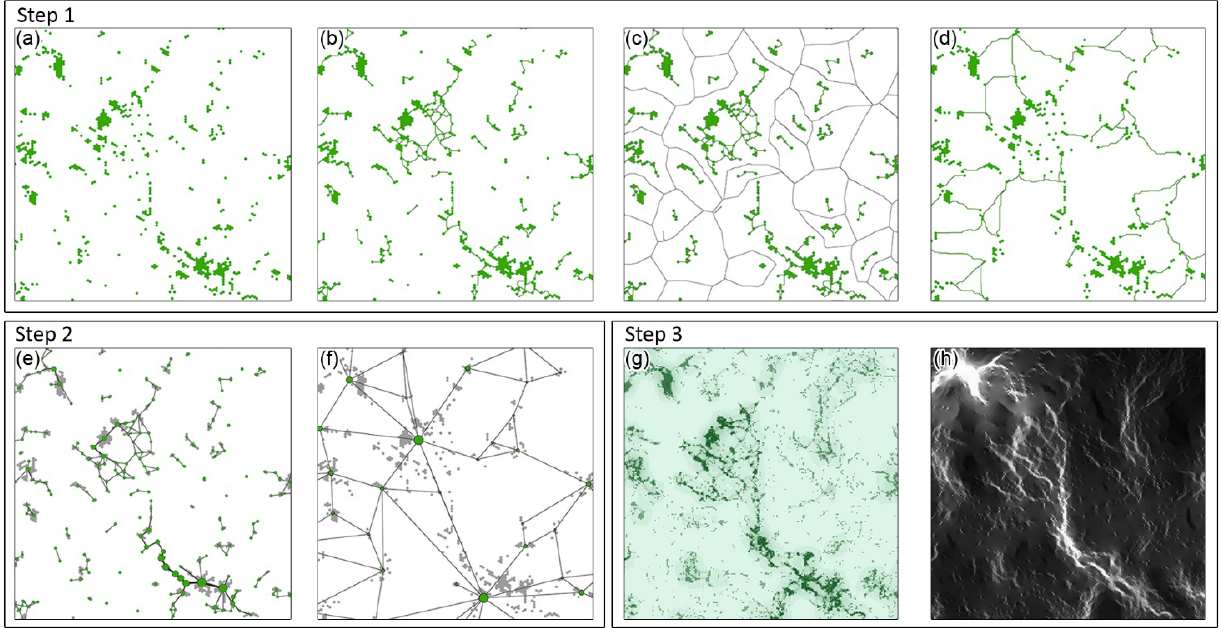
Figure 2. An illustration of the mapping process. Step 1: (a) identify habitat patches; (b) map LCPs between habitats; (c) iden- tify home ranges by grouping connected habitat patches; (d) map LCPs between home ranges. Step 2: (e) assess habitat accessibility based on graph analyses; (f) assess home range accessibility based on graph analyses. Step 3: (g) create a conductance surface for circuit modelling based on landscape accessibility (dark green areas are high conductance to movements, while light green areas are low conductance); (h) map the flow of forest migration (white areas) by circuit theory-based